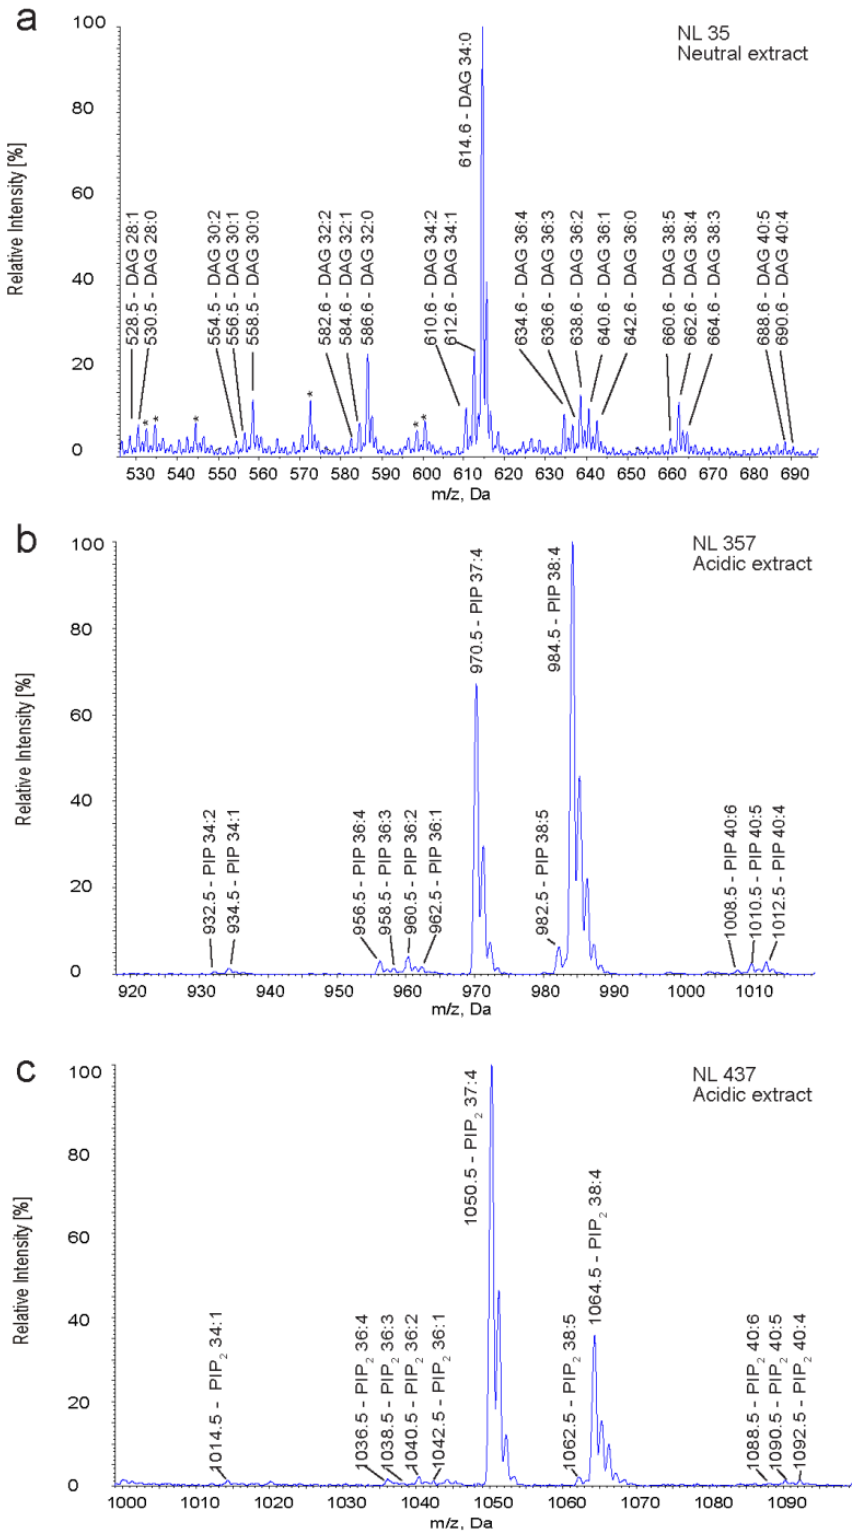
Figure 4. Identification of DAG, PIP and PIP molecular species in human T cells by 2 neutral loss scanning for lipid class-specific fragments. ( a ) DAG species identified by scanning for neutral losses of 35 Da in neutral extracts. Asterisks indicate unidentified peaks. ( b ) PIP and ( c ) PIP species identified by scanning for neutral losses of 357 Da 2 (PIP) and 437 Da (PIP ) in acidic 2